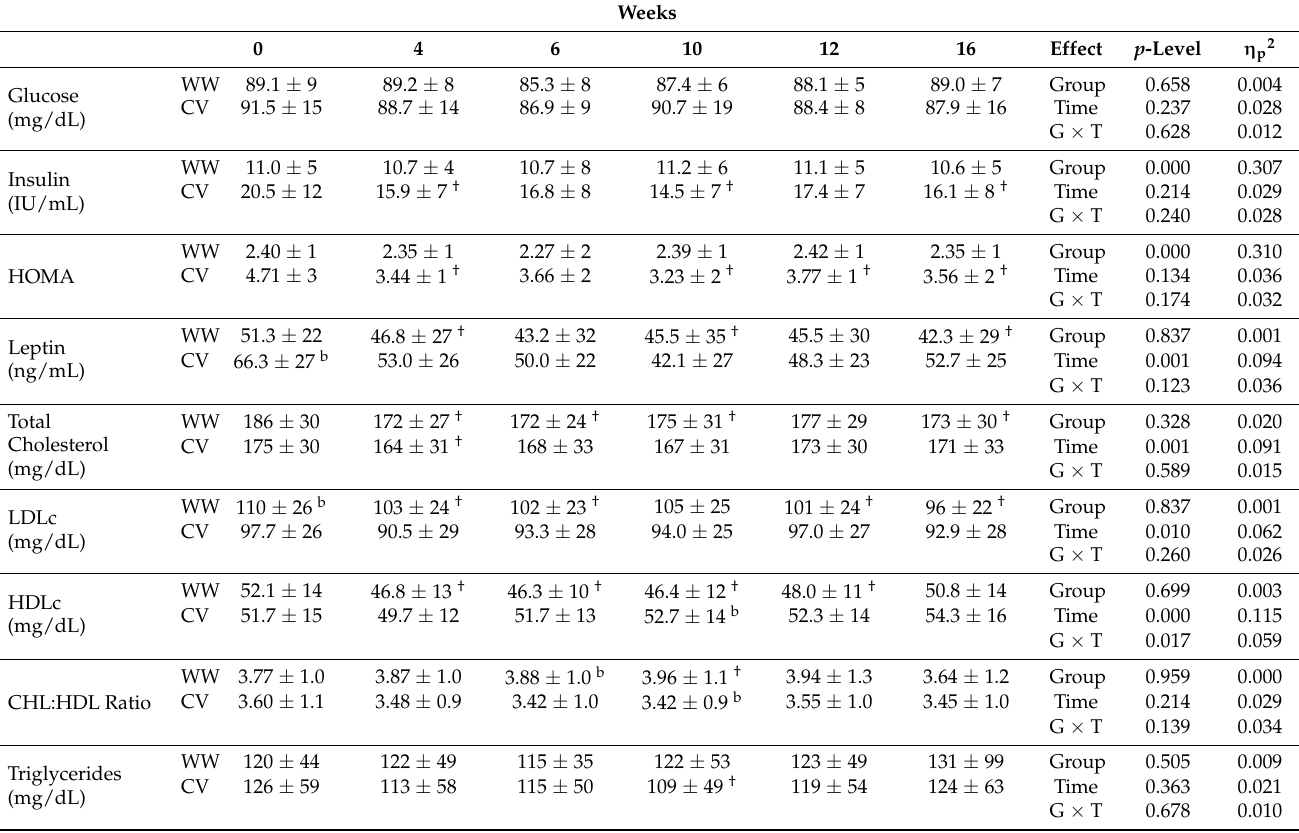
Table 2. Metabolic and Hormone